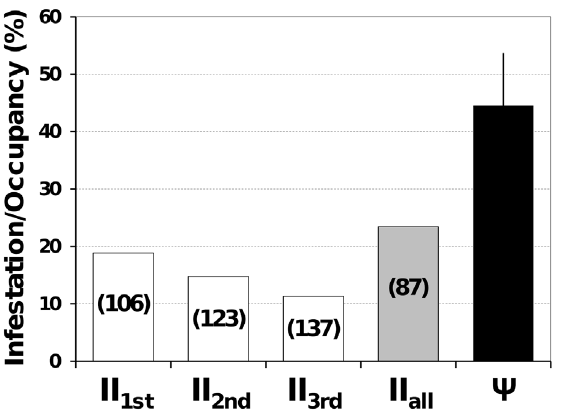
Figure 3. Infestation by synanthropic Triatominae in 414 man- made ecotopes of the Jaguaribe valley, Ceara´, Brazil. II, naı¨ve infestation index from results of single vector-search rounds (II 1st to II 3rd ) and all rounds combined (II all ); Y , model-averaged site-occupancy estimate (error bar, 85% confidence interval). The estimated numbers of infestation foci that went undetected during single vector-search rounds and all rounds combined are shown inside the corresponding bars.